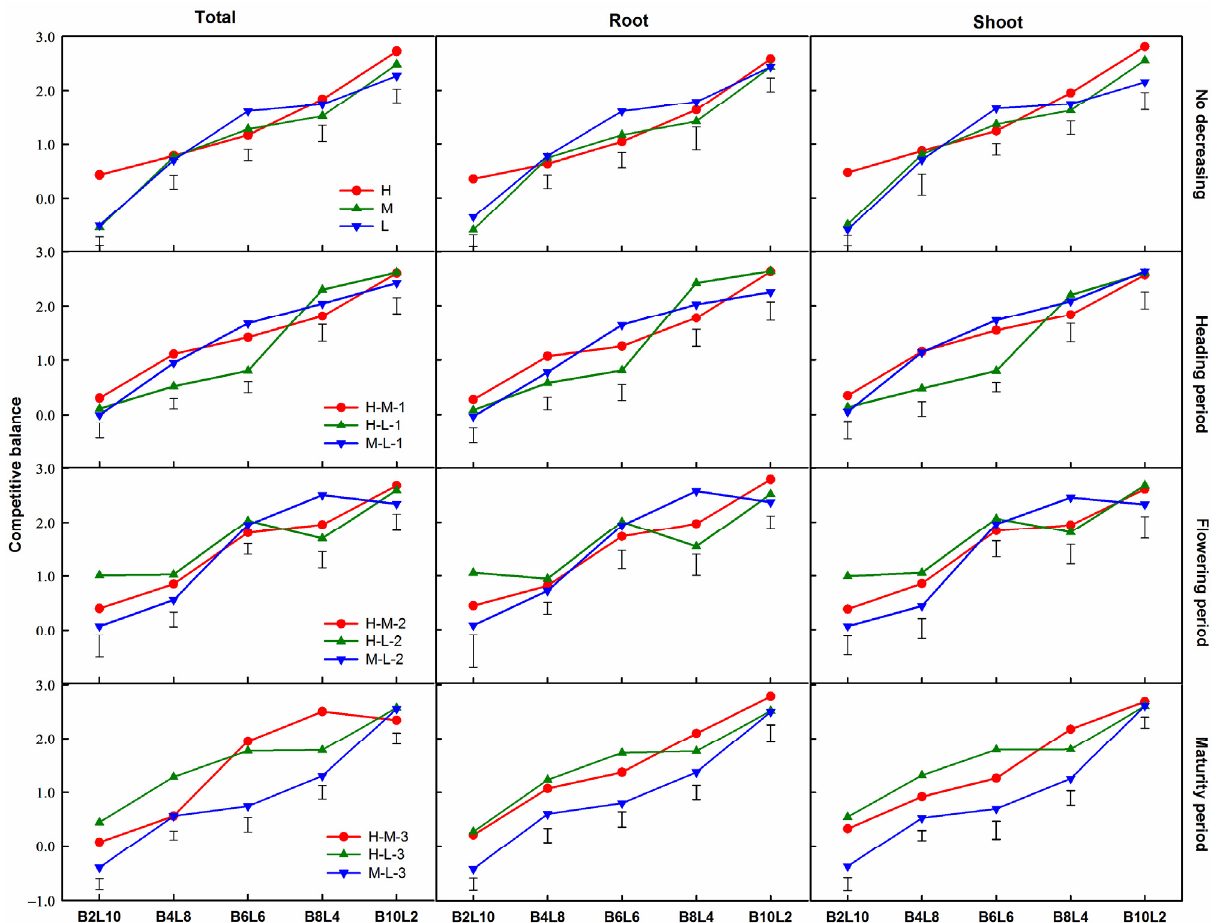
Figure 5. Competitive balance index (CB) calculated from total biomass, shoot biomass, and root biomass of B. ischaemum (B) in the mixtures with L. davurica (L) under soil water decreasing treatments. Vertical bars represent LSD 0.05 values.